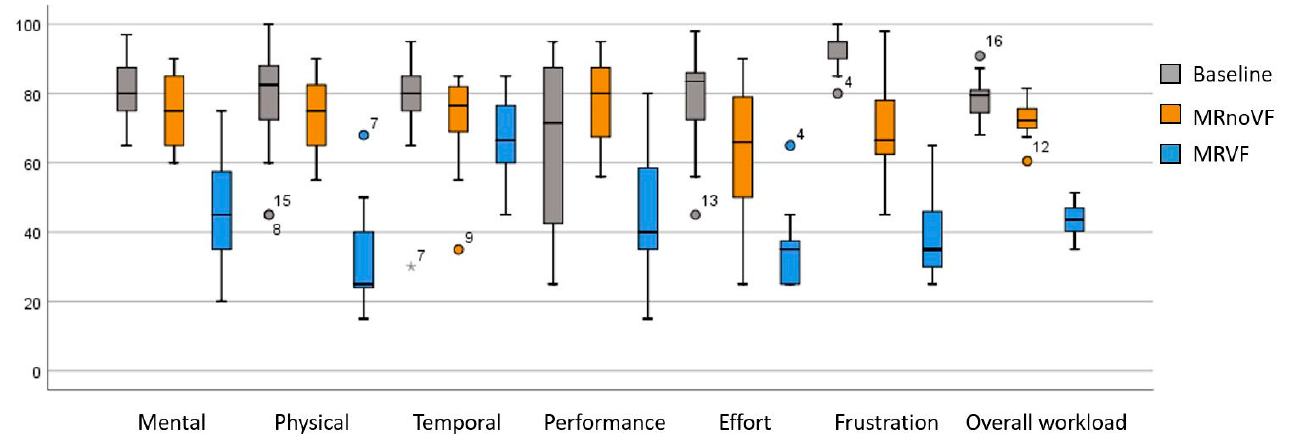
Figure 11. Subjective NASA-TLX ratings of task workload across all conditions in the tele-welding tasks. The special symbols (circles and asterisks (*)) are outliers in the data, representing that they are outside of a certain range indicated by the boxes in the box plot. The numbers next to the circles and asterisks indicate which observations in the dataset are outliers.